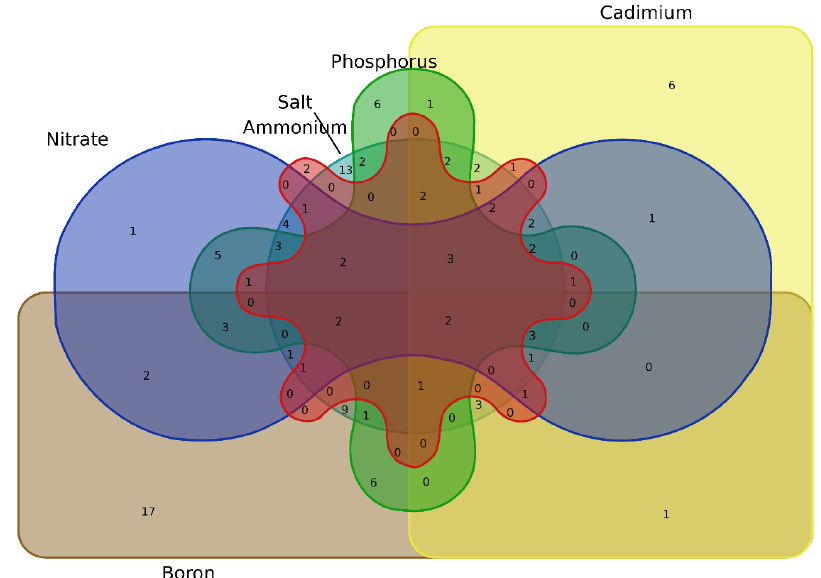
Figure 14. Venn diagram showing the common and specific differentially expressed genes of Bna- GARPs under diverse nutrient stresses. GARPs under diverse nutrient